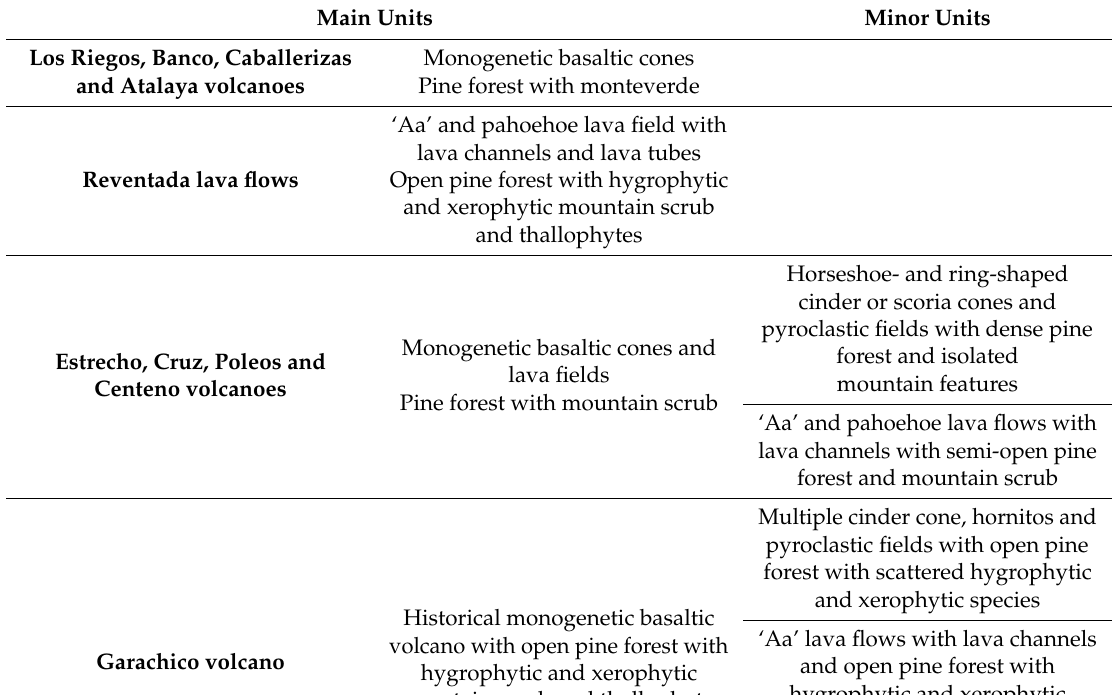
Table 2. Landscape units of the Chinyero Special Nature Reserve.